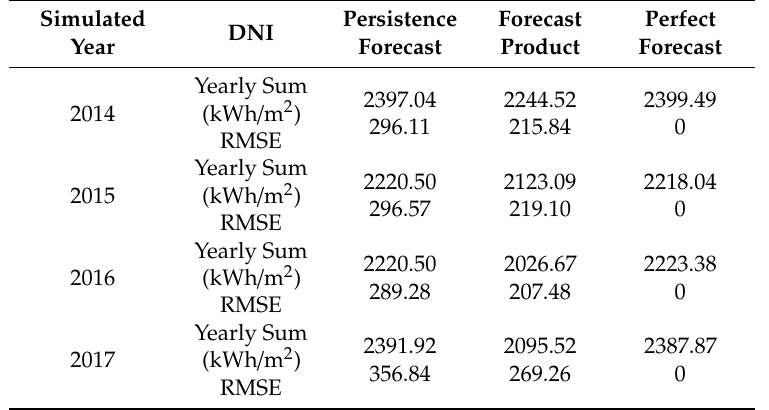
Table 2. Weather data direct normal irradiation (DNI) yearly sum and root-mean-square error (RMSE).